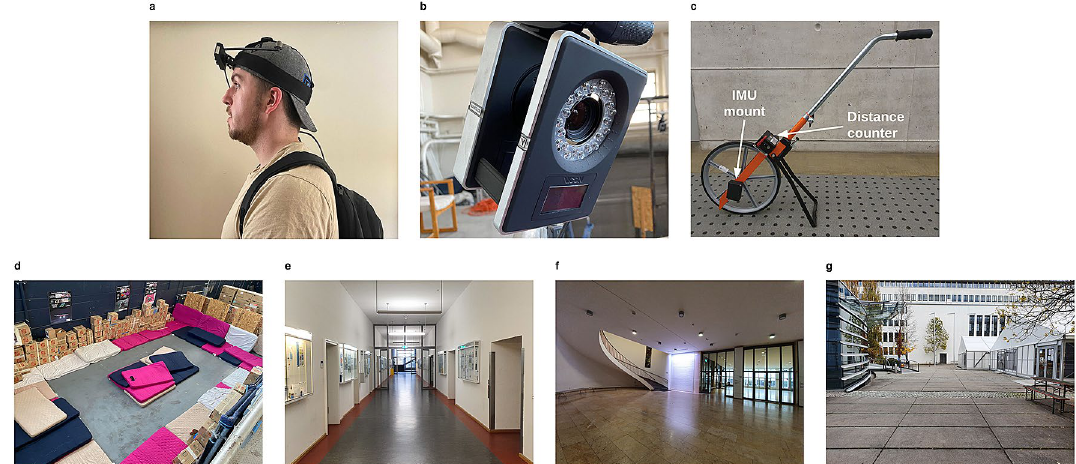
Figure 1. Equipment used for the two studies and snapshots of the four environments where data was recorded (all photographs taken by the authors). ( a ) Subject wearing head mount with T265 and tracking marker. ( b ) One of the Vicon Vantage cameras used in the optical tracking space. ( c ) Perambulator with distance counter and IMU mount. ( d ) Optical tracking space. ( e ) Hallway environment. ( f ) Lobby environment. ( g ) Courtyard